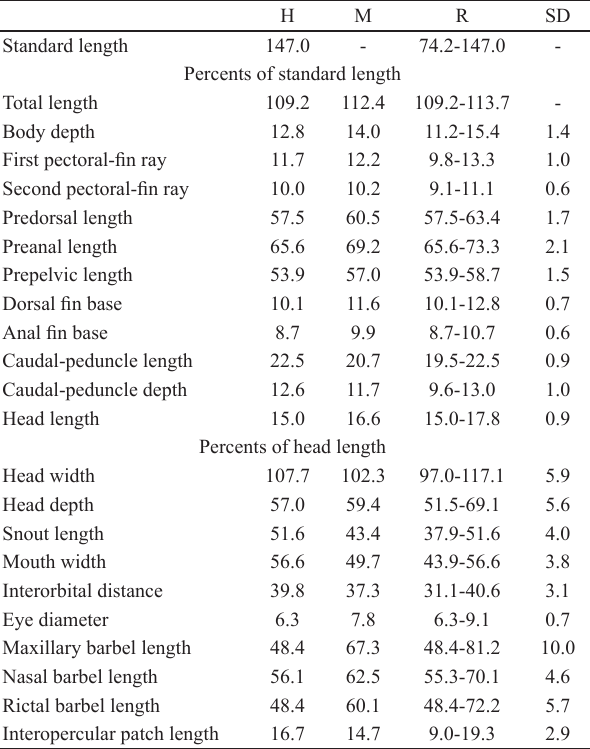
Table 1. Morphometric data for holotype (H) and 11 paratypes of Trichomycterus steindachneri . Standard length (SL) expressed in mm. Measurements expressed as percents of SL or head length (HL). M: mean; R: range; SD: standard